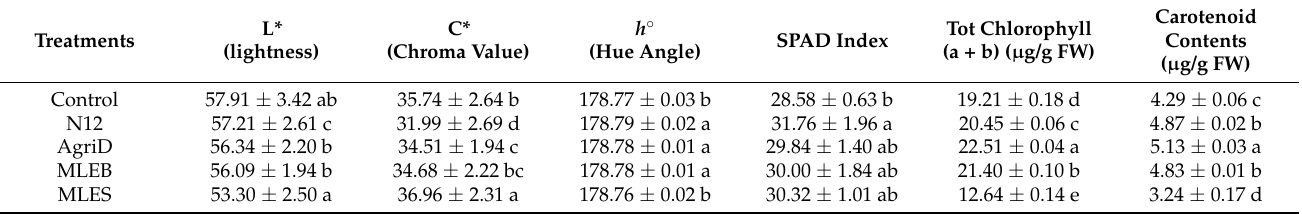
Table 4. Effect of biostimulant application on leaf colour, SPAD index and pigment contents of